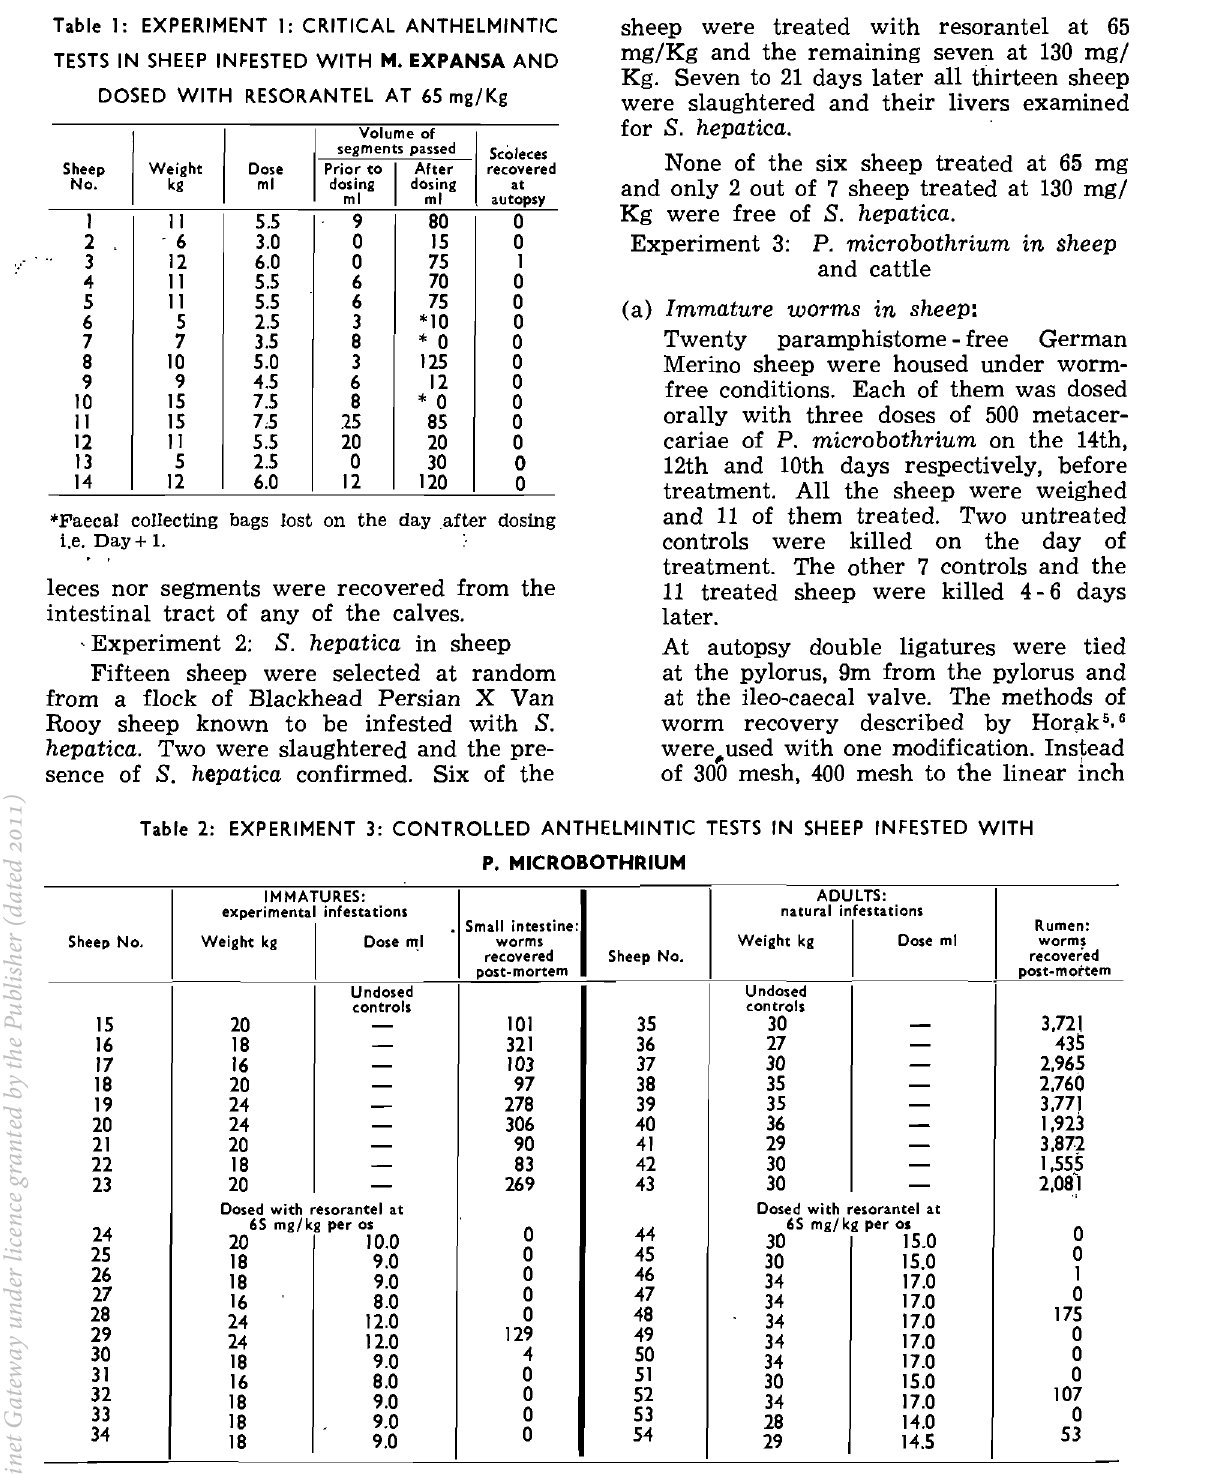
Table I: EXPERIMENT I: CRITICAL ANTHELMINTIC TESTS IN SHEEP INFESTED WITH M. EXPANSA AND DOSED WITH RESORANTEL AT 65 mg/Kg